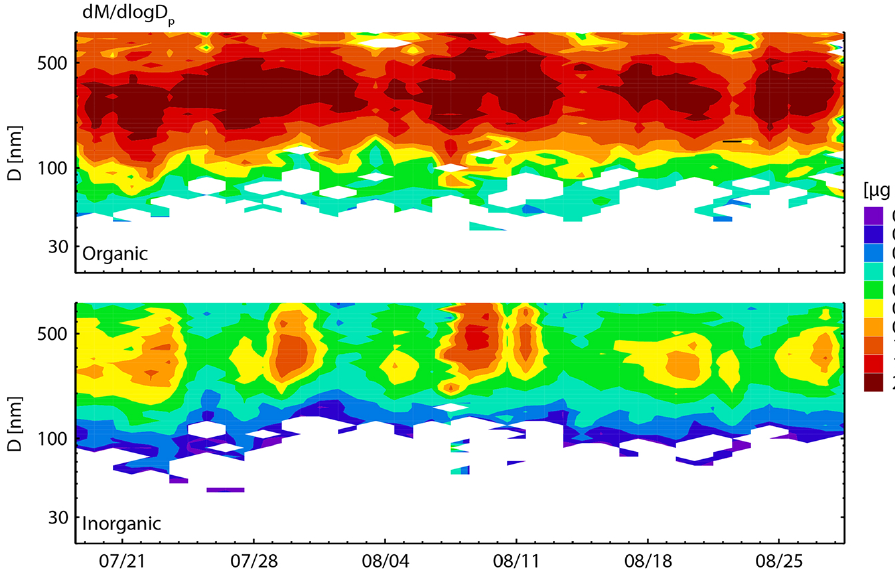
Fig. 2. Organic (top) and inorganic (bottom) mass distributions measured by the AMS during BEACHON-RoMBAS